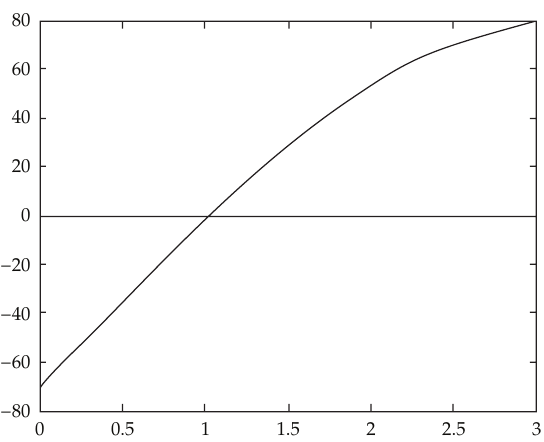
Figure 4: g (cid:2) γ (cid:3) on the interval (cid:8) 0 , 3 (cid:9) for cone (cid:2) 1 (cid:3) of Example 2.1 at x k (cid:7) (cid:2) − 7 , 6 (cid:3)